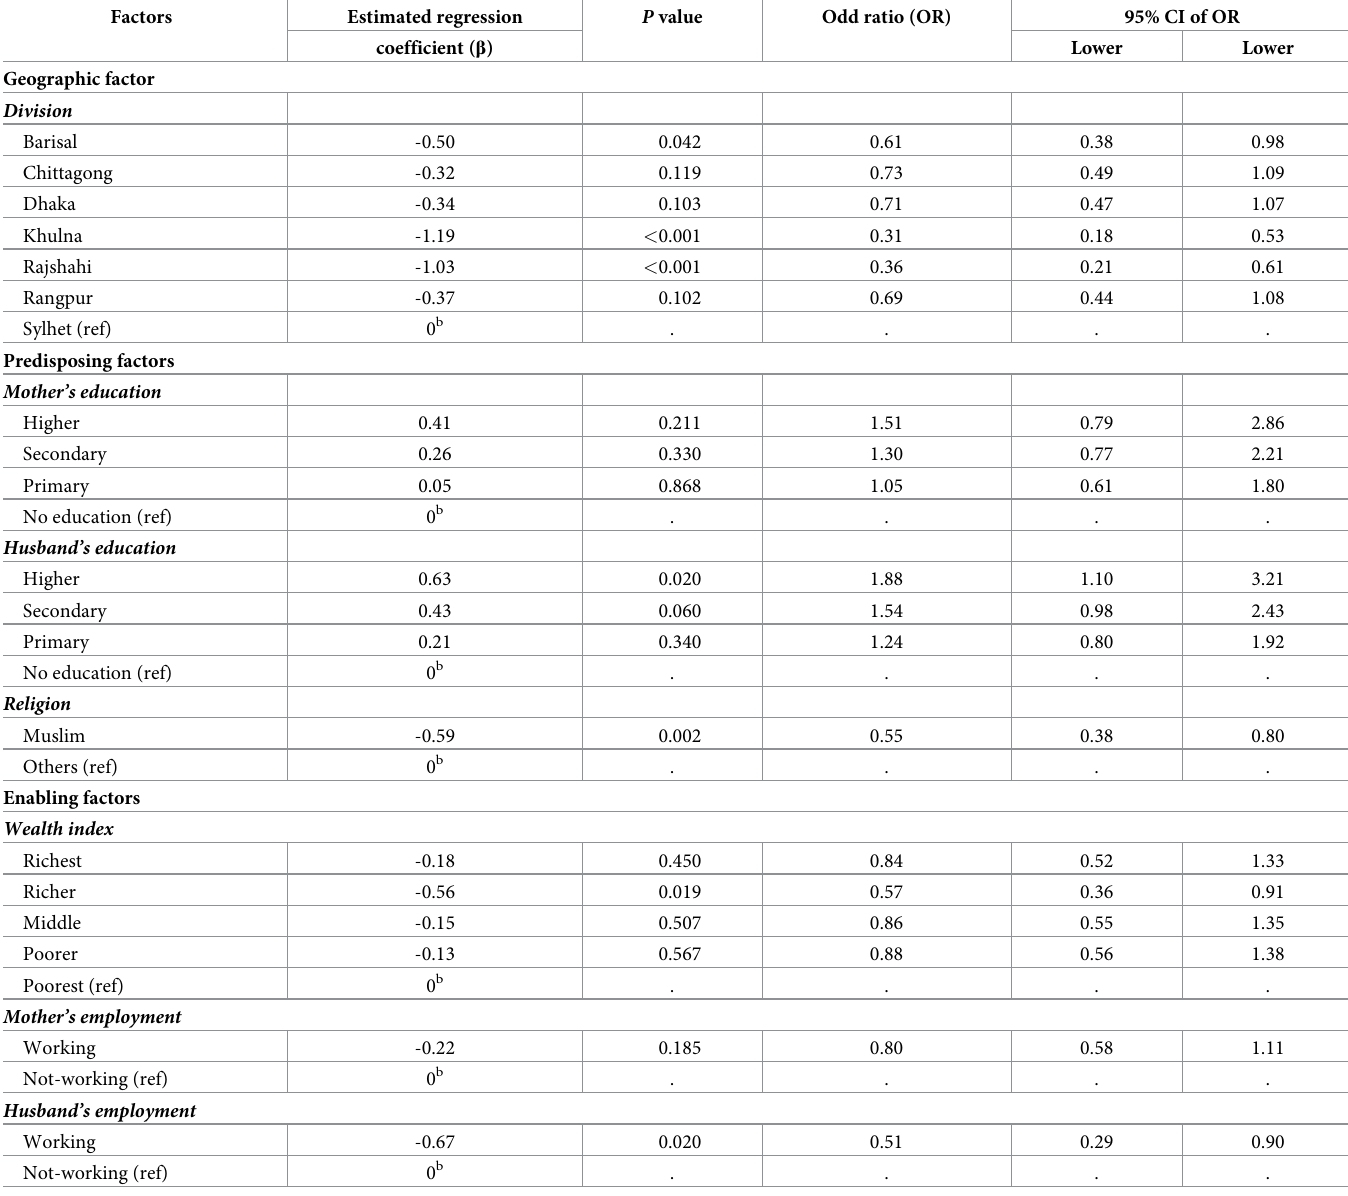
Table 4. Results of binary logistic regression analysis to identify the factors associated with the ANC contacts by qualified doctors.